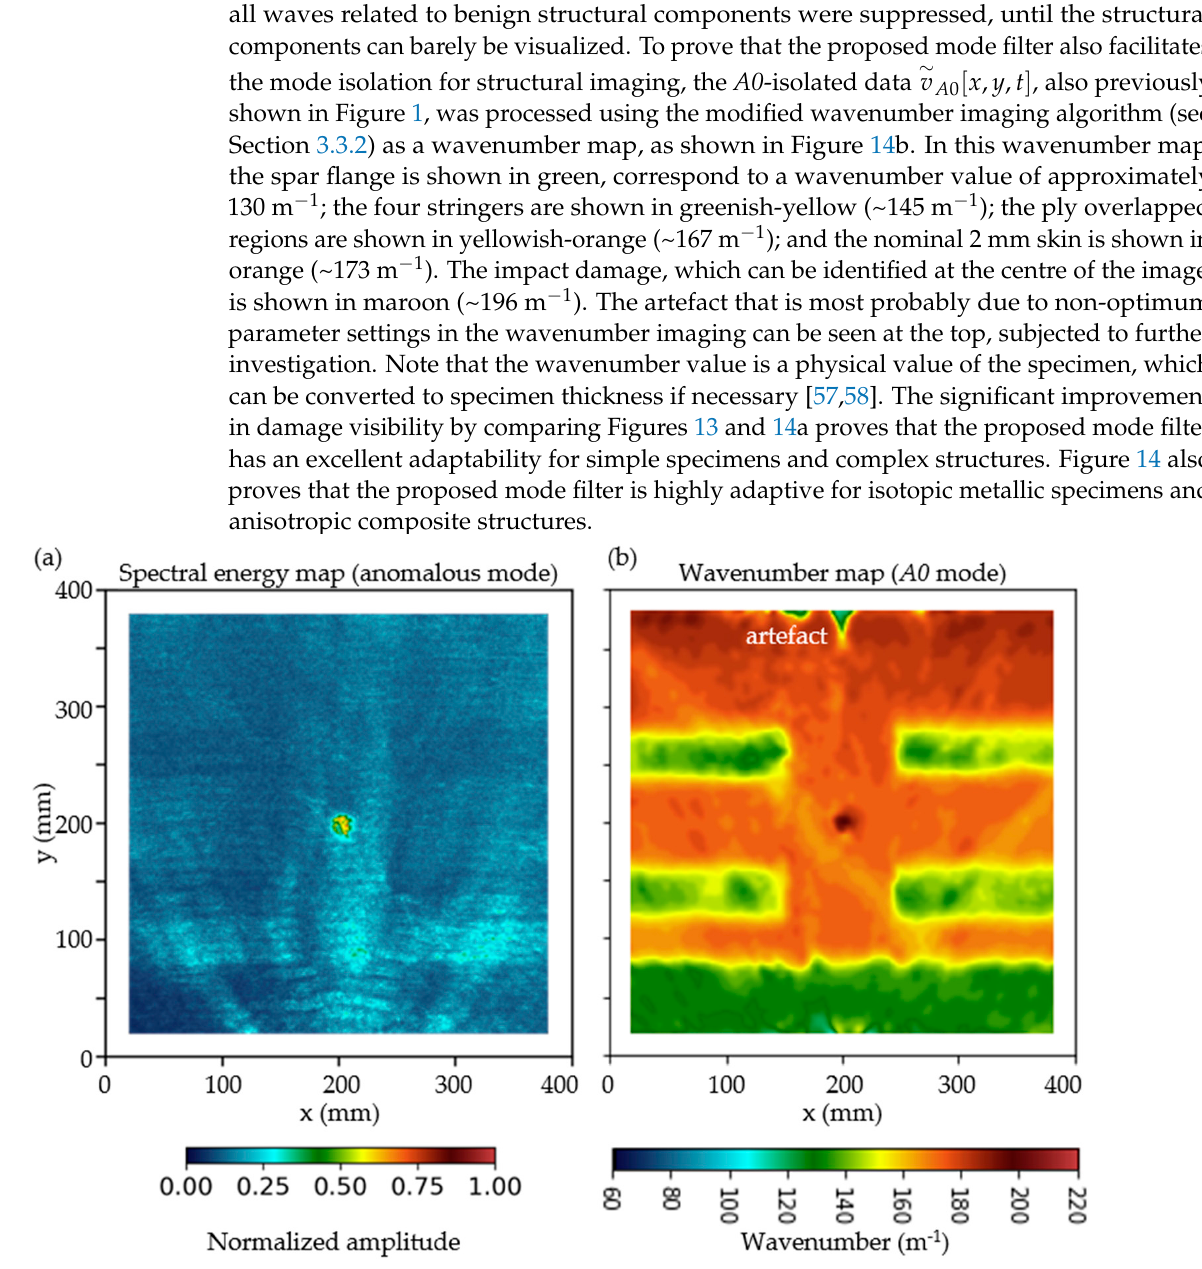
Figure 14. Inspection result of Case D4. ( a ) Spectral energy map suppresses the visibility of benign structural components while highlighting the impact damage. ( b ) The wavenumber map shows the existence of structural components and at the same time allows the visualization of impact damage.